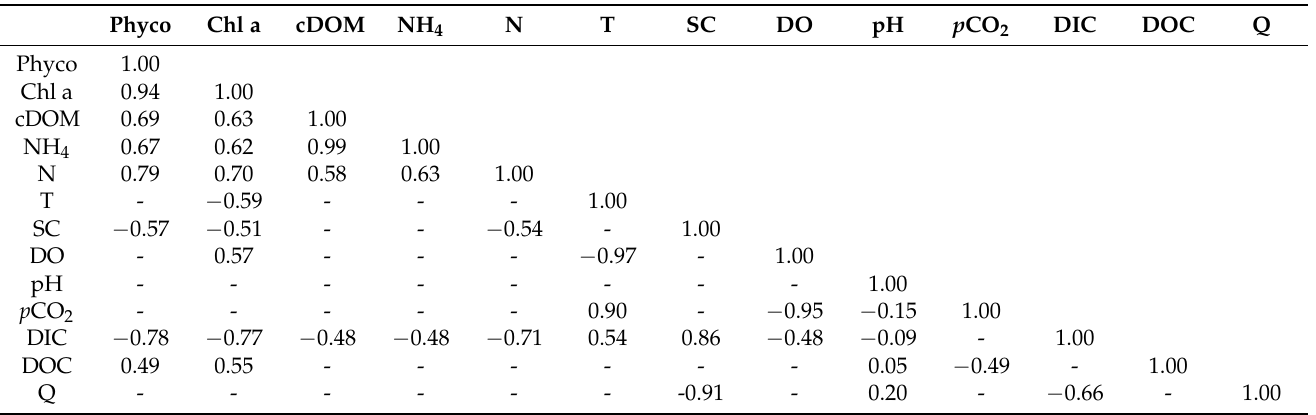
Table 5. Pearson correlation coefficients for measured parameters. Phycocyanin (Phyco),